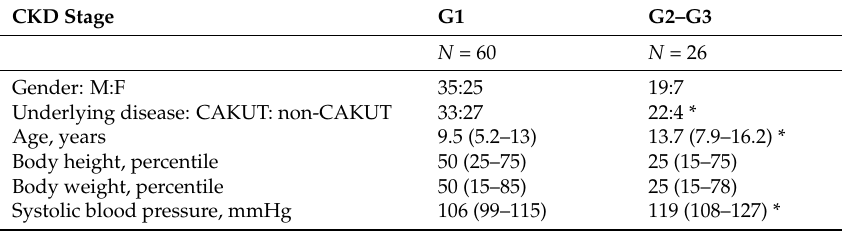
Table 1. Anthropometric and biomedical characteristics in children and adolescents with chronic kidney disease (CKD) stage